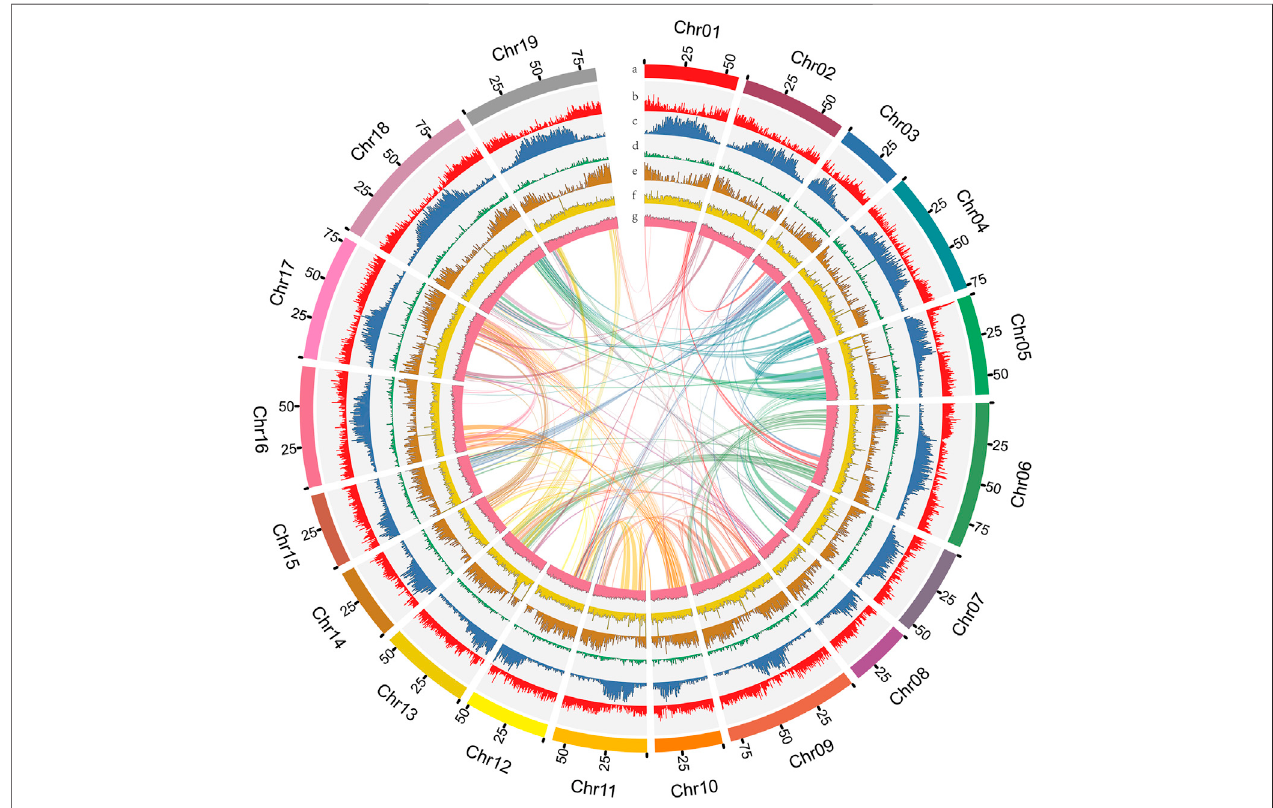
FIGURE2| Thegenomefeaturesof Dendrobiumnobile . (A) Chromosomes. (B) LTRGypsydensity. (C) LTRCopiadensity. (D) DNAtransposondensity. (E) Gene density. (F) Coverage of second-generation data. (G) GC content within sliding windows of 500 kb.